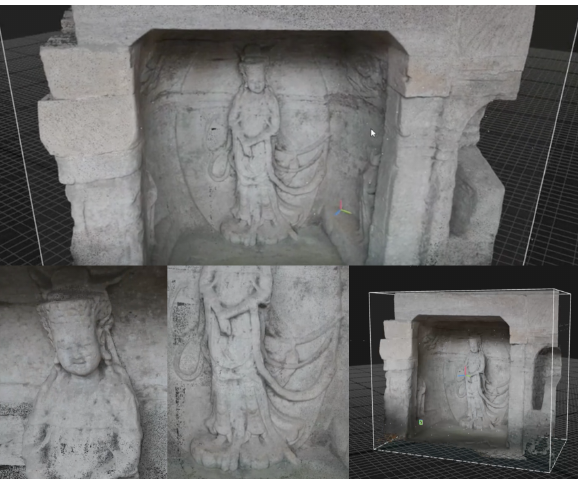
Figure 9: Niche No.253 “Bodhisattva and Ksitigarbha” deities. Point cloud